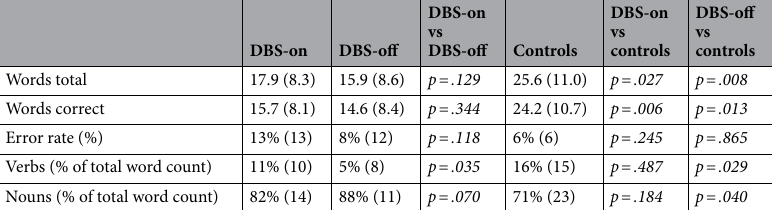
Table 3. VF task results. Overview of the mean VF performance (standard deviation in brackets) in the phonemic, non-alternating task and associated p values for between and within group comparisons, respectively. Correct word count is computed as the number of total words minus false responses. Error rates were calculated as the percentage of false responses per total word count; verb and noun ratios were computed as the number of words belonging to the respective lexical class per total word